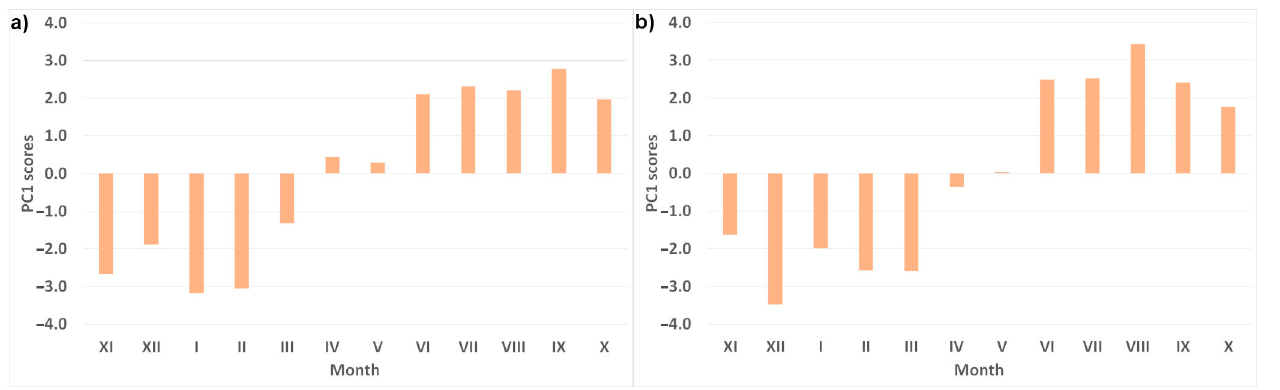
Table 5. The WQIs calculated based on the annual average parameters. Site No.